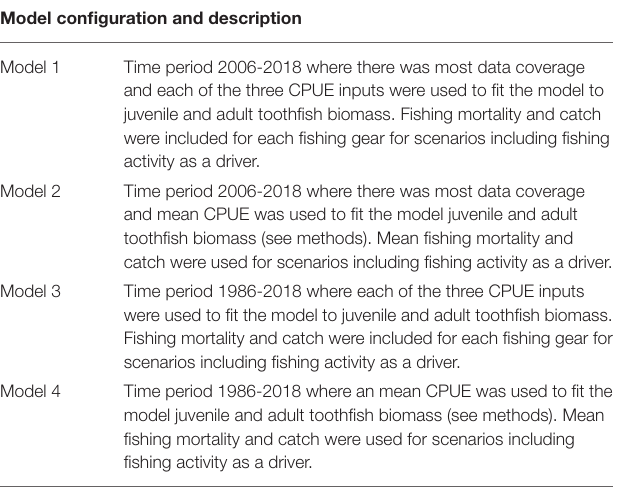
TABLE 1 | Model configurations used to calibrate Ecosim. TABLE 2 | Vulnerabilities estimated in the best-fitting scenario for model 1 that were used in model